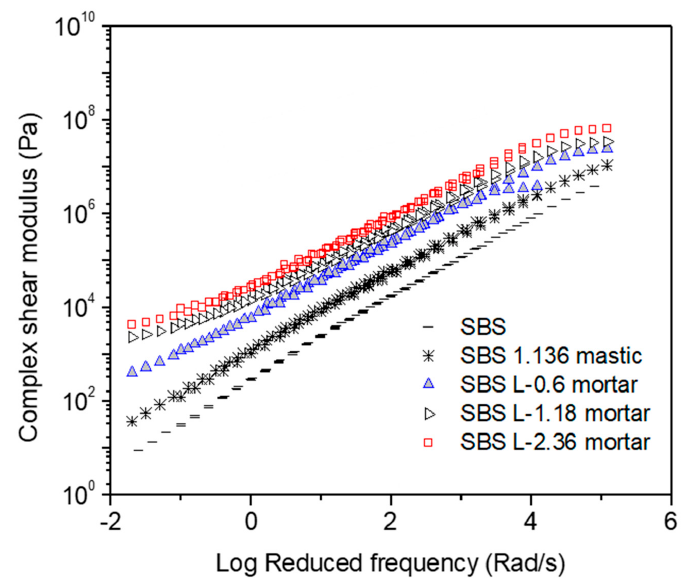
Figure 3. Complex modulus master curves of AC ‐ 20 based asphaltic materials including SBS modified asphalt binder, mastic and mortar at a reference temperature of 60 °C.